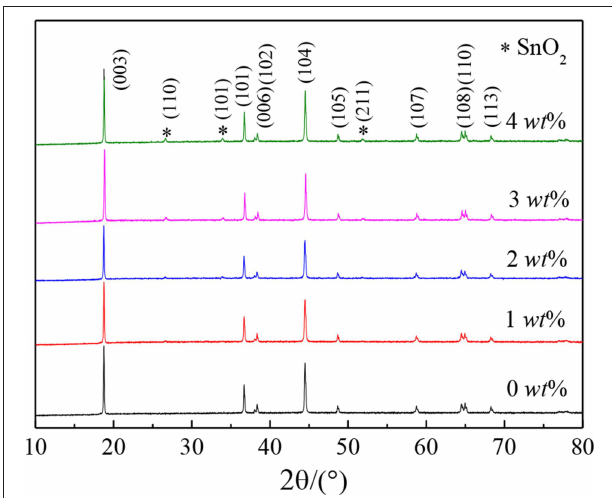
FIGURE 1 | The XRD patterns of the 811 and x wt% SnO 2 -modified 811 ( x = 0, 1, 2, 3, 4) materials.